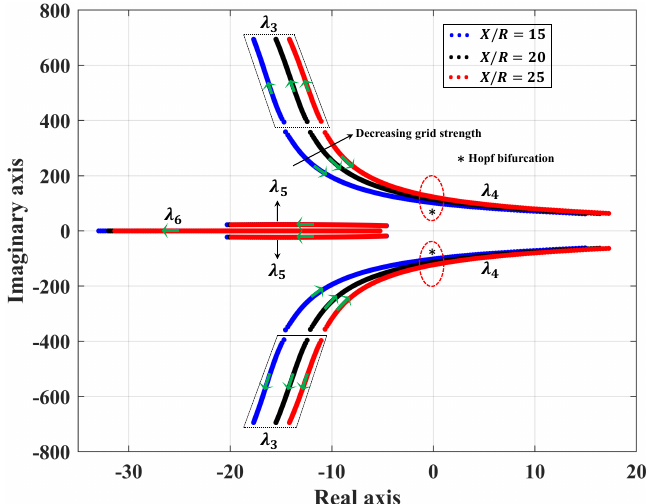
Figure 5. Eigenvalue trajectories for different grid strengths.